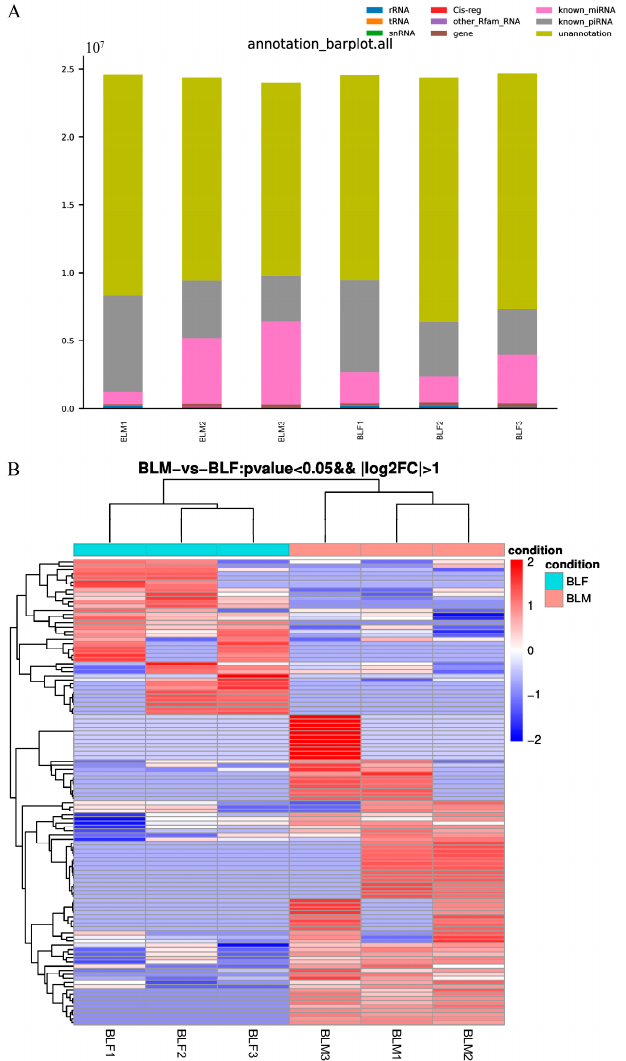
Figure 2. The classification and annotation of all reads and differentially expressed piwi-interacting RNAs from small RNA sequencing results. ( A ) Bar plot of the classification and annotation of all reads in the male and female groups. The x -axis represents the sample, and the y -axis represents the number of reads of various small RNAs. Annotated non-coding RNAs included ribosomal RNAs, transfer RNAs, small nuclear RNAs, Cis-reg, other Rfam RNA, gene, microRNAs, and piwi-interacting RNAs. ( B ) Hierarchical cluster analysis of 114 differentially expressed piwi-interacting RNAs between the male and female group based on transcripts per million values. The thresholds for the identification of differentially expressed piwi-interacting RNAs were p < 0.05 and |log 2 fold change| > 2.